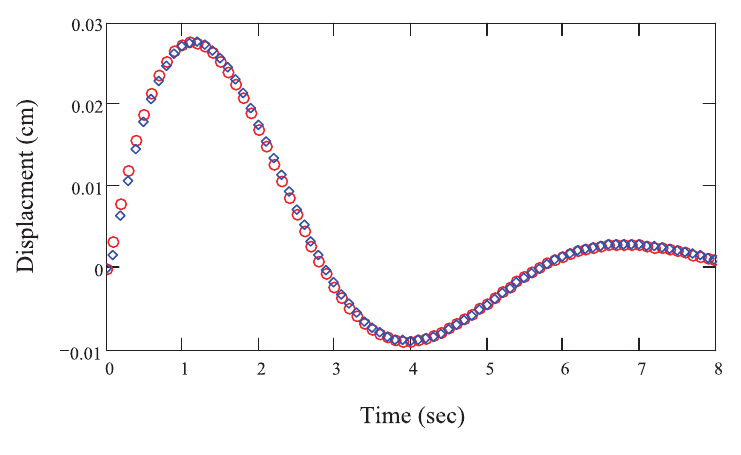
Fig. 3. Time invariance